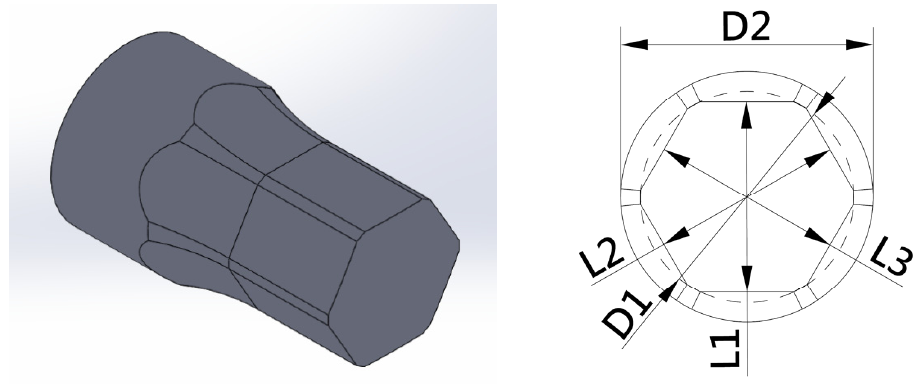
Figure 2. CAD drawings ( left ) and specifications ( right ) of hexagonal punches.